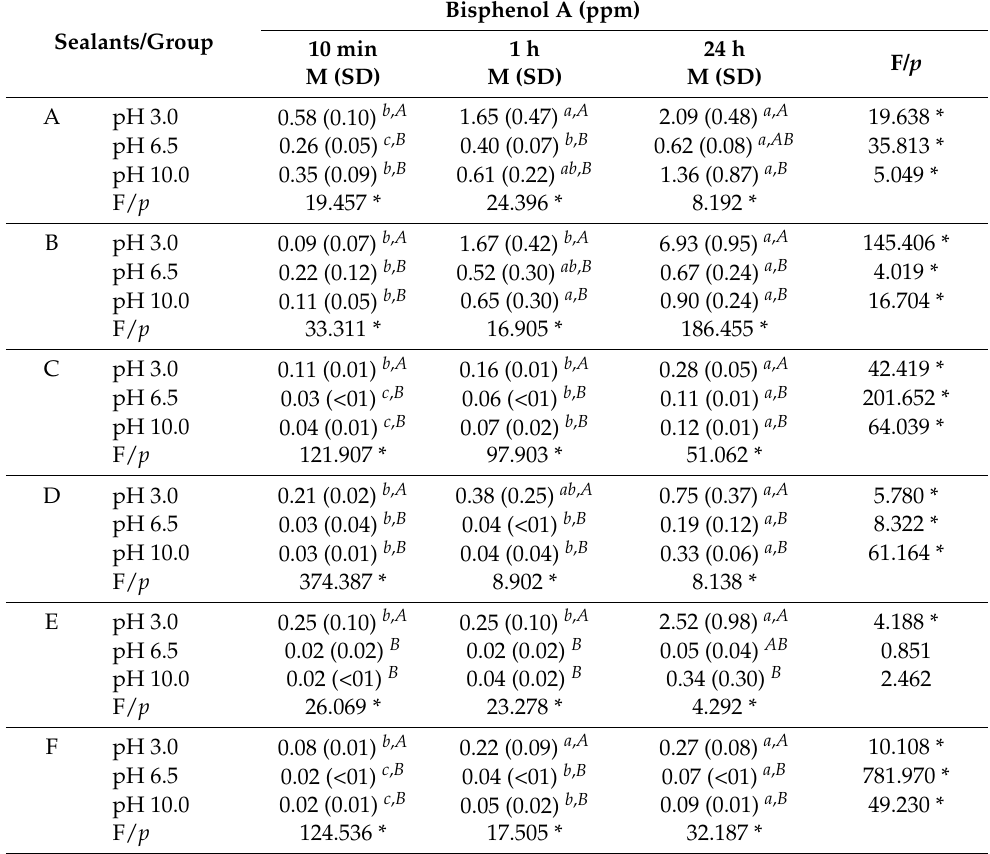
Table 6. BPA concentration (ppm) according to pH levels and time of each sealant.